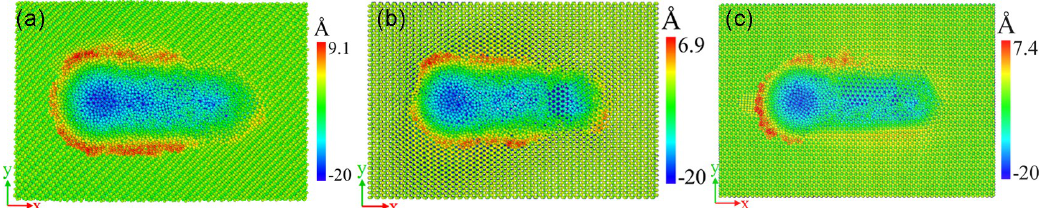
Figure 9. Top view of deformation behaviors of GaAs at a sliding distance of 10nm for ( a ) GaAs(001), ( b ) GaAs(110), and ( c ) GaAs(111). The scratching depth is 1.5 nm. Atoms are colored by heights in z direction.